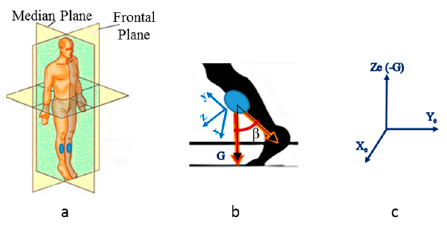
Figure 2. Reference systems.